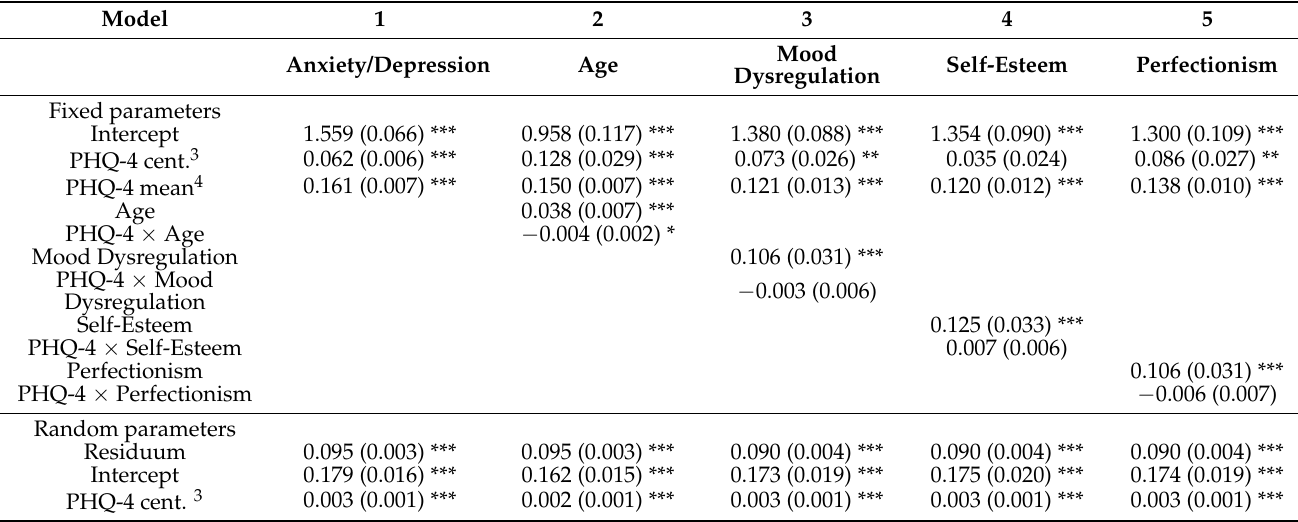
Table 2. Results of the HLM (maximum likelihood) models for the association of eating disorder symptomatology and anxiety/depression 1 and effects of moderators 2